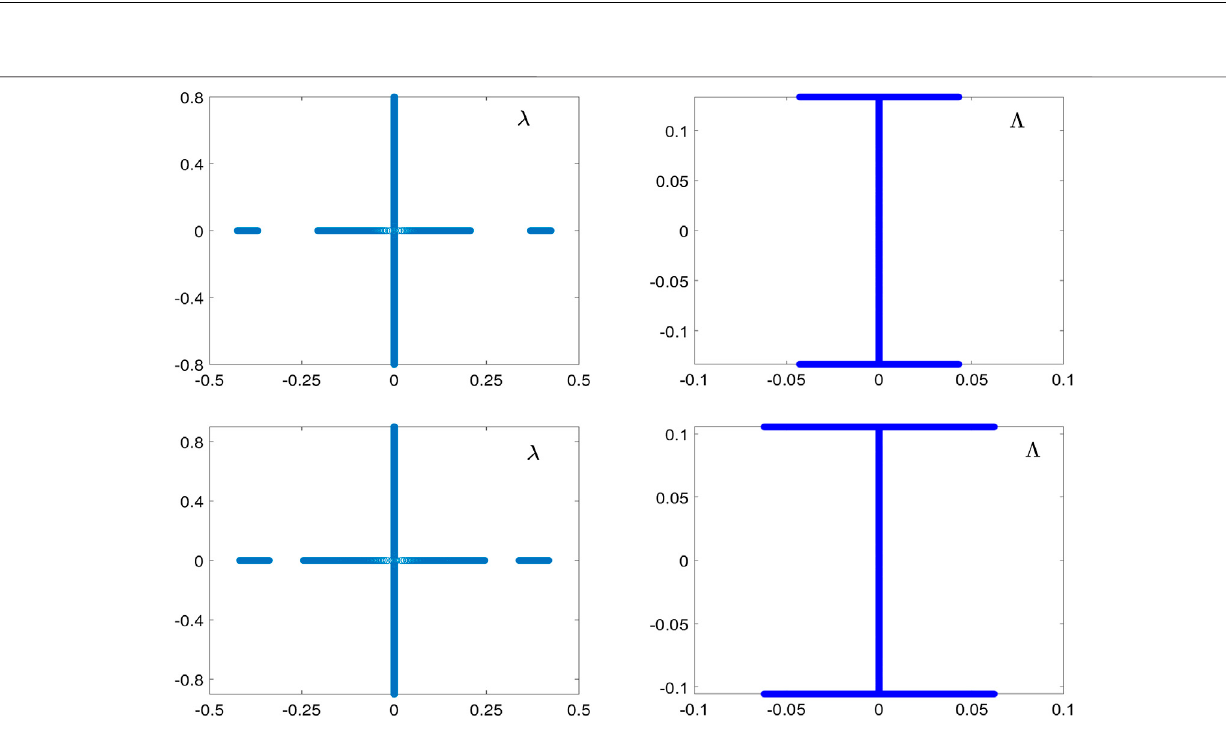
(cid:15)(cid:15)(cid:15)(cid:15) (cid:16) P ( λ ) when λ